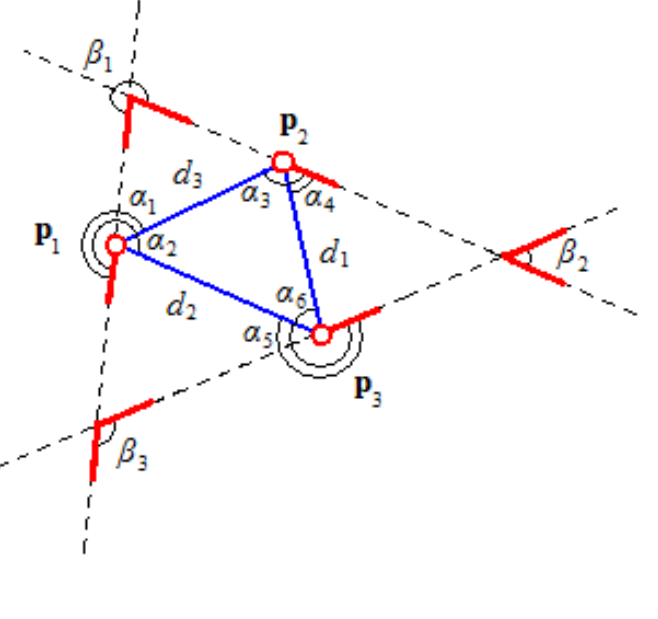
Figure 4. The components of the new feature representation proposed in this